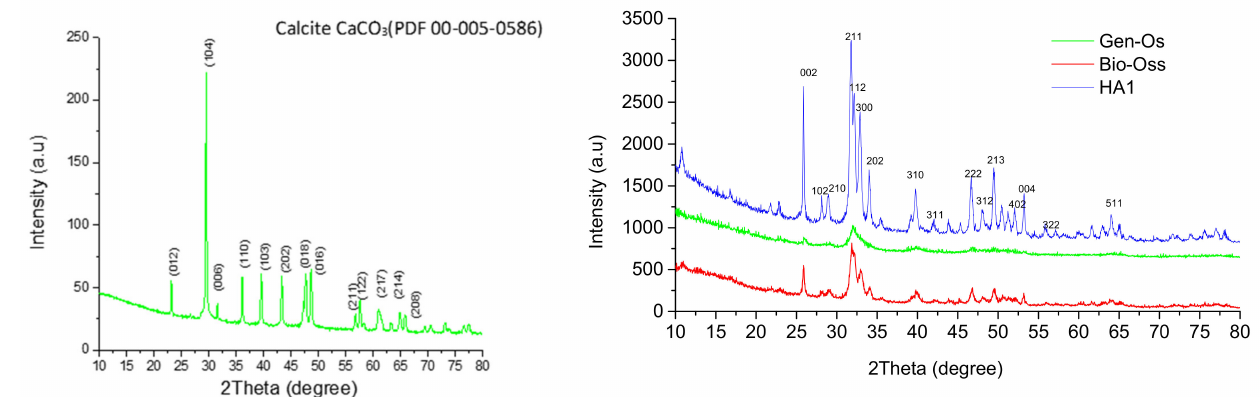
Figure 1. XRD plot for: ( left ) hen egg-shell powder before calcination; ( right ) HA1, Bio-Oss, and Gen-Os powders.